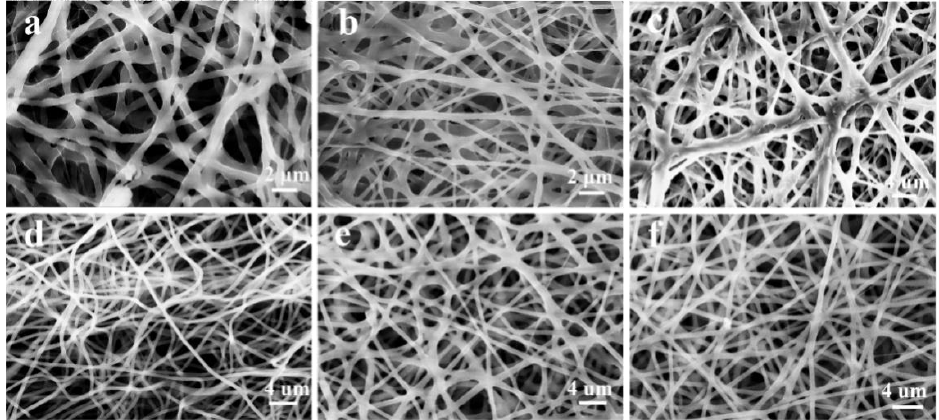
Figure 1. Figure 1. SEM images of composite spinning films: ( a ), PCL/PEO; ( b ), PCL/PEO/CS; ( c ), PCL/PEO/CTAB 1 ; ( d ), PCL/PEO/CS/CTAB 0.2 ; ( e ), PCL/PEO/CS/CTAB 0.4 ; ( f ), PCL/PEO/CS/CTAB 0.6 .